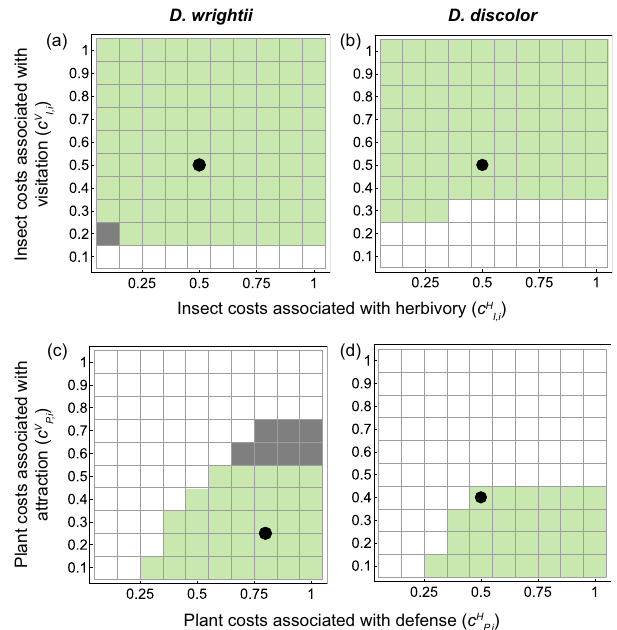
Fig. 5 Varying the costs associated with plant and insect traits reveals coevolutionary outcomes. Insect costs associated with herbivory ( c H I,i ) and visitation ( c V I,i ) are varied in panels ( a , b ) and plant costs associated with defense ( c H P,i ) and attraction ( c V P,i ) are varied in panels ( c , d ) (Methods). Green regions indicate evolutionary transitions from antagonism to net mutualism. Gray regions indicate that the interaction is net antagonistic despite evolutionary co-option of the antagonist. White regions indicate evolutionary purging of the antagonist. Black points give evolutionary parameter values used in the model